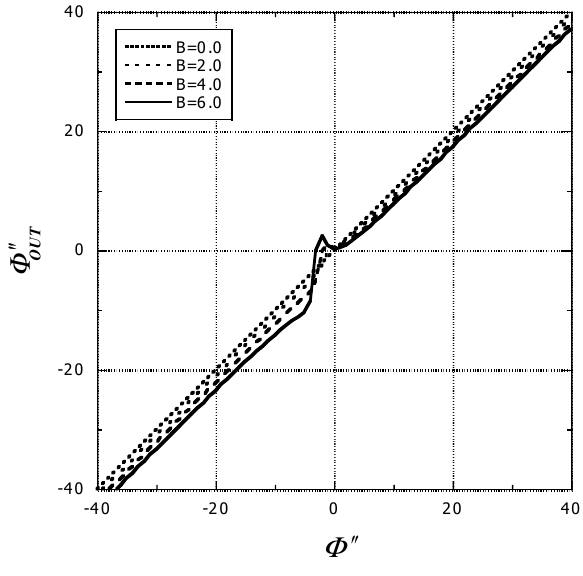
Figure 1. Group Delay Dispersion (GDD) of the output pulse Φ GDD ′′Φ for various values of B